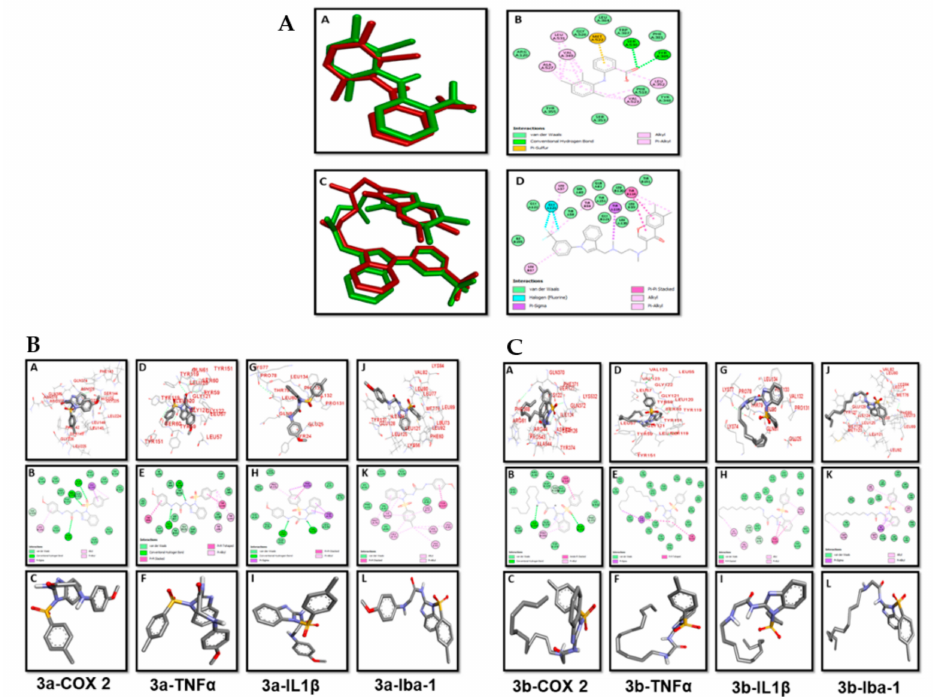
Figure 2. ( A ) Pose analysis and 2D depictions for meclofenamic acid ( A , B ) and 6,7-dimethyl-3-[(methyl{2-[methyl({1-[3-(trifluoromethyl)phenyl]-1h-indol-3-yl} methyl)amino]ethyl} amino)methyl]-4h-chromen-4-one ( C , D ) in the protein structures of cyclooxygenase-2 (COX-2) and tumor necrotic factor (TNF α ), respectively (green = co-crystallized ligand, red = re-docked ligand). ( B )PostdockinganalysisvisualizedbyDiscoveryStudioVisualizerinboth2Dand3Dposes. Interactions between 3a and COX2 ( A , B ), TNF- α ( D , E ), interleukin (IL)-1 β ( G , H ), and ionized calcium-binding adapter molecule (Iba-1) ( J , K ). 3D poses ( A , D , G , J ) and 2D ( B , E , H , K ). ( C , F , I , L ) represents the best pose of 3a that fitted to COX2, TNF- α , IL-1 β , and Iba-1, respectively. ( C ) Post docking analysis visualized by Discovery Studio Visualizer in both 2D and 3D styles. Interactions between 3b and COX2 ( A , B ), TNF- α ( D , E ), IL-1 β ( G , H ), Iba-1 ( J , K ). 3D style ( A , D , G , J ) and 2D style ( B , E , H , K ). ( C , F , I , L ) represents the best pose of 3b that fitted to COX2, TNF- α , IL-1 β , and Iba-1,